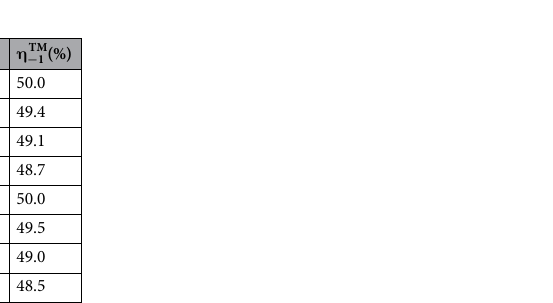
Figure 4 expresses the efficiency versus grating groove depth about TE and TM polarizations in the − 1st and the 0th orders. In Fig. 4, the red curves based on the simplified modal method can be agreed with the blue curves on account of RCWA for both two-polarized lights. Because of neglecting the reflection of the grating propagating modes at the grating boundary surface, the diffraction efficiencies obtained by using simplified modal method are slightly larger than the numerical results obtained by employing RCWA.